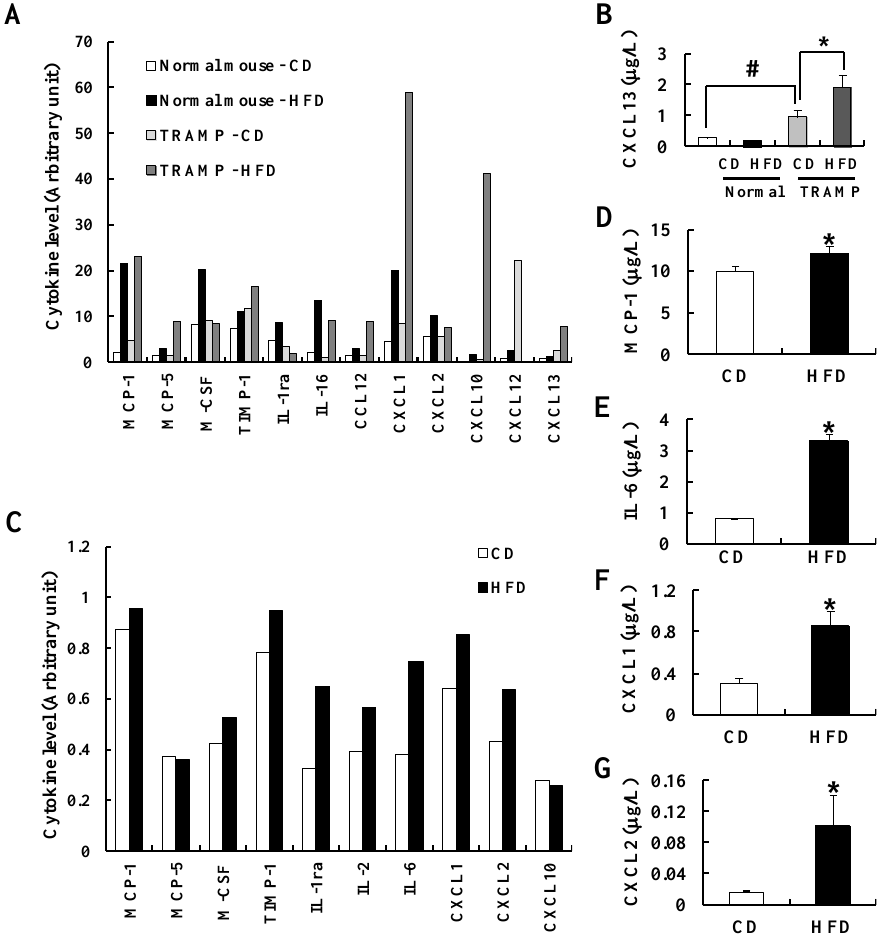
Figure 5. HFD feeding induces the changes in cytokine levels. ( A , B ) Four-week-old TRAMP mice and their normal littermates were fed a CD or HFD for 20 weeks and sera were prepared; ( C – G ) Adipose tissue conditioned media (ACTM) were prepared from 20-week-old mice that had been fed the CD or HFD for 16 weeks. The relative levels of cytokines in the pooled serum samples (normal, 6 mice/group; TRAMP, 12 mice/group) ( A ) and ATCM (5 mice/group) ( C ) were estimated by Proteome Profiler™ (mouse cytokine array) as described in the Materials and Methods section; ( B , D – G ) The concentrations of CXCL13 in serum ( B ) and the concentrations of MCP-1, IL-6, CXCL1, and CXCL2 in ATCM ( D – G ) were determined by ELISA. Each bar represents the mean ± SEM. # p < 0.05 between normal mice and TRAMP mice. * p < 0.05 as compared with the CD-fed